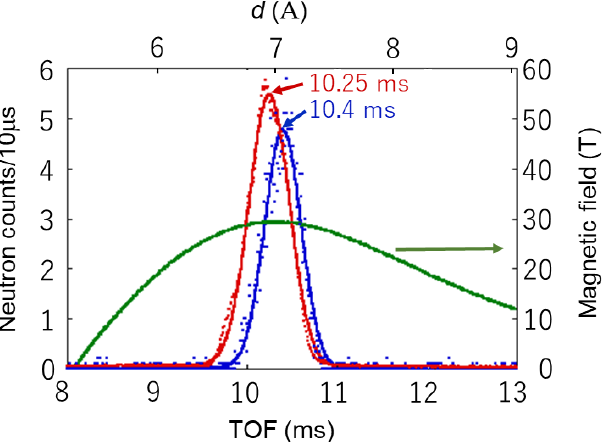
Figure 10. TOF spectrum and interplanar spacing ( d ) with (30 T, in blue) and without (in red) the magnetic field and an example of the pulsed magnetic field waveform (in green) applied to the sample.